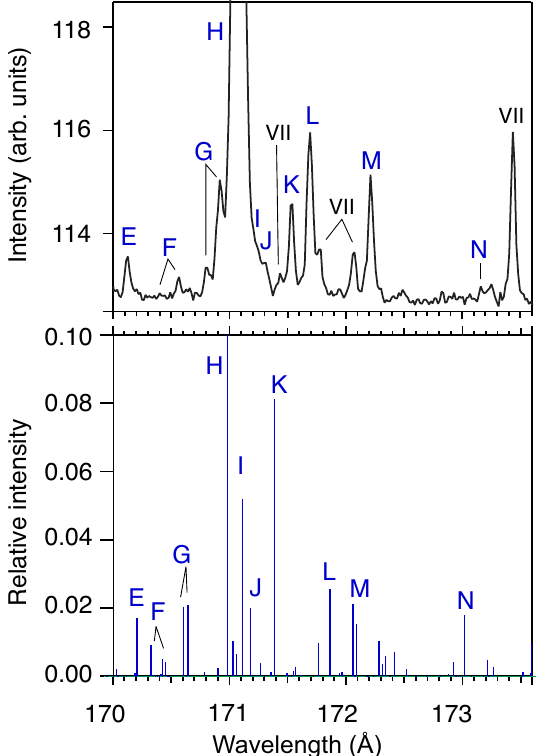
Figure 2. Comparison of measured spectral emission ( top ) with model predictions ( bottom ). The ex- perimental data were produced at a nominal electron energy of E beam = 170 eV. Predictions are based on MRMP and CRM calculations from Beiersdorfer et al. [25] performed at an electron density of 10 10 cm − 3 and an electron temperature of 54 eV. The calculations are normalized to the predicted intensity of line H , the Fe IX line at 171